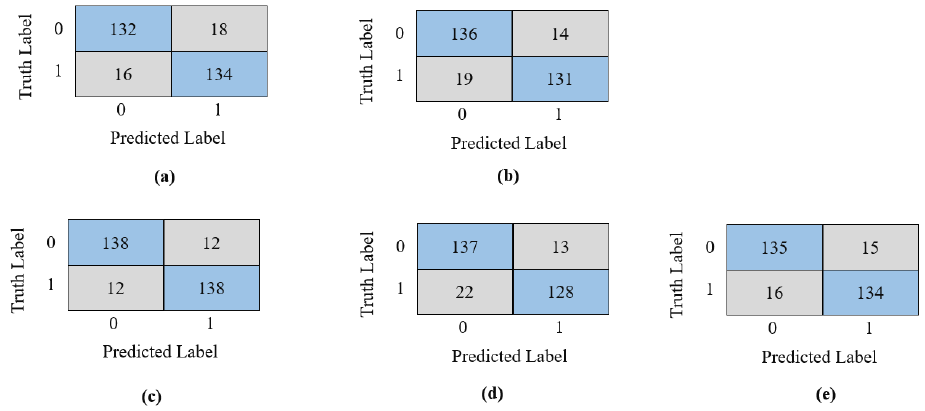
Figure 8. Confusion matrix of the five models ( a ) VGG19, ( b ) EfficientNetB0, ( c ) Xception, ( d ) Mo- bileNetV2, and ( e )